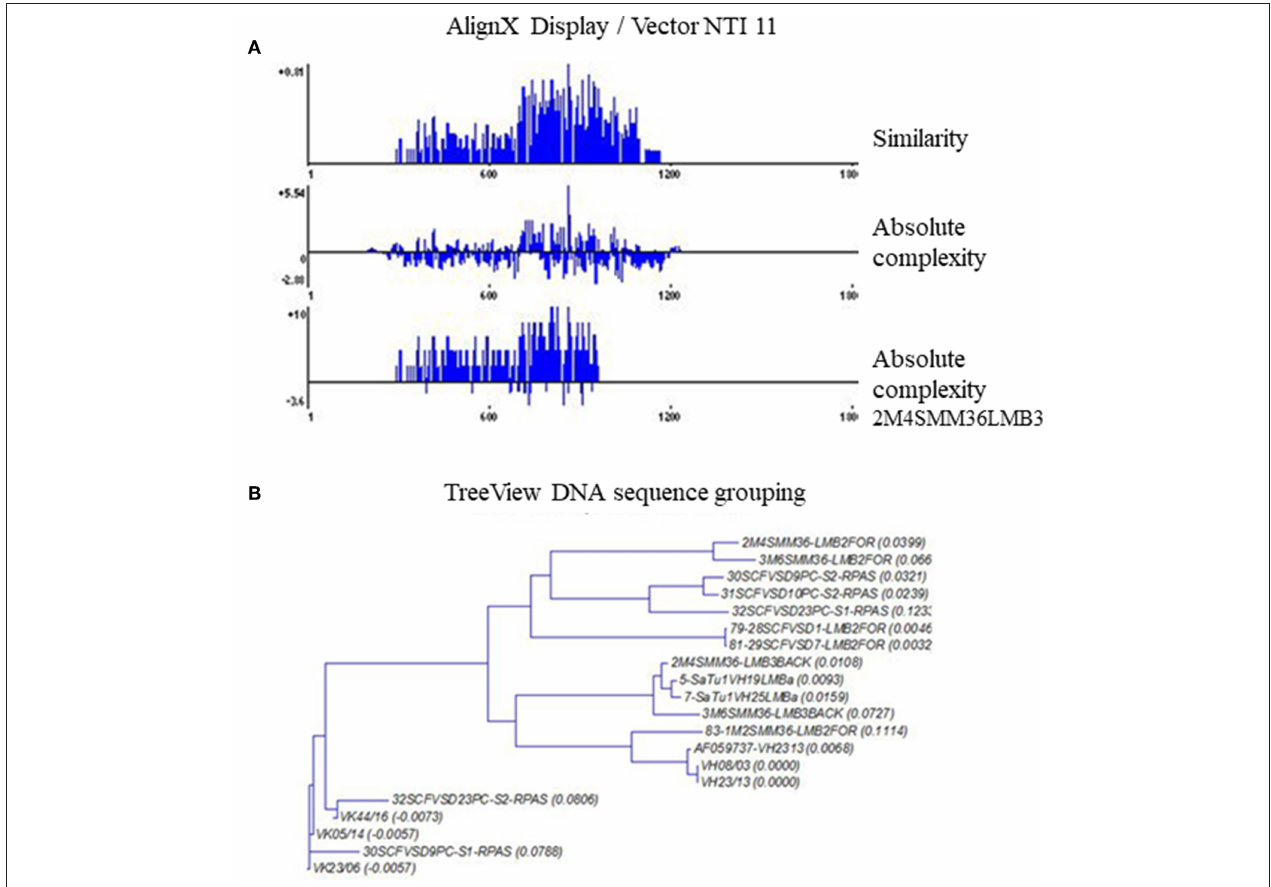
FIGURE 7 | TreeView image to identify the aligned immunoglobulin variable gene regions highest similarity level. Cloned and randomly selected antibody variable region sequences in melanoma were subject to a detailed comparative DNA analysis by Clustal W, TreeView, and Vector NTI 11, in order to reveal DNA sequences with high homology to consensus. The levels of matches and mismatches in different parts of the aligned DNA sequences are indicated (A) . TreeView image shows the representative results, where melanoma tissue originated antibody variable region gene inserted clones represented substantial similarities to the previously defined anti GD3 antibody variable heavy chain sequences (B)